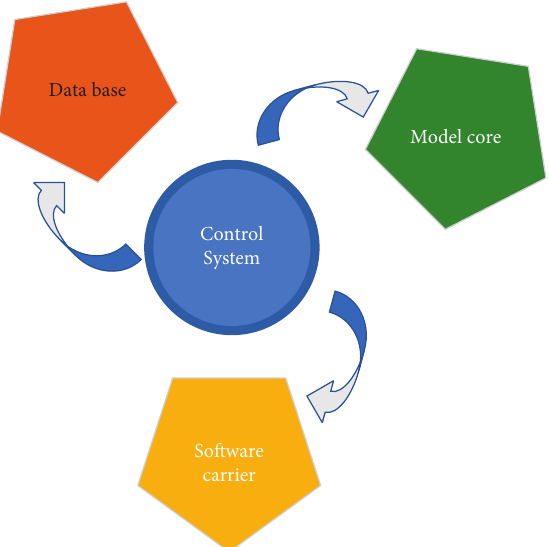
Figure 2: A framework of the interaction between the virtual space and the real space of